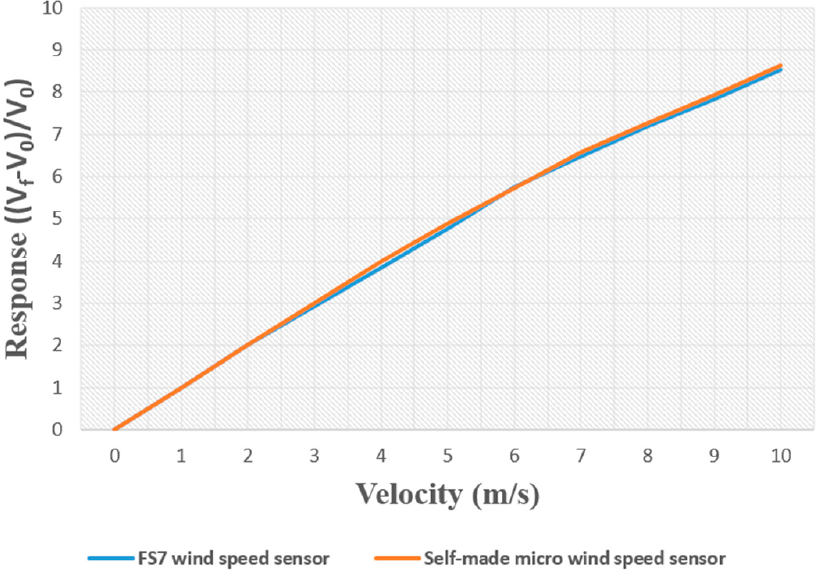
Figure 8. Calibration and comparisons of home-built flexible micro air velocity sensor and commercial air velocity sensor at 25 °C.